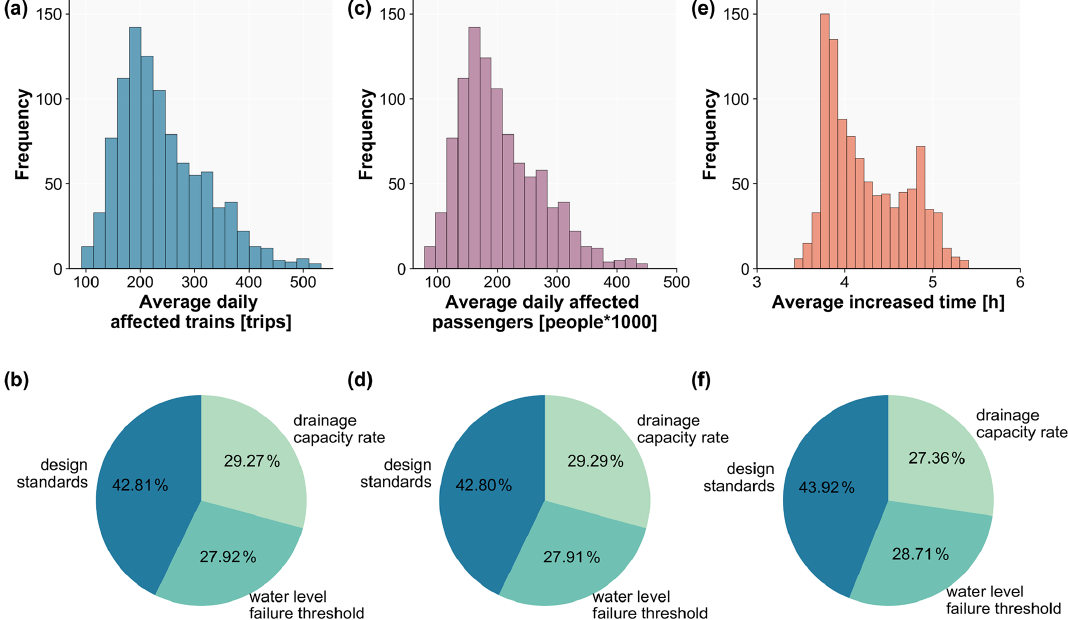
Figure 8. Results of the uncertainty (histograms) and sensitivity (pie charts) analyses for the performance metrics. Panels (a) and (b) show the average daily affected trains, (c) and (d) average daily affected passengers, and (e) and (f) average increased time. Figure A7 provides the results of the other performance metrics.